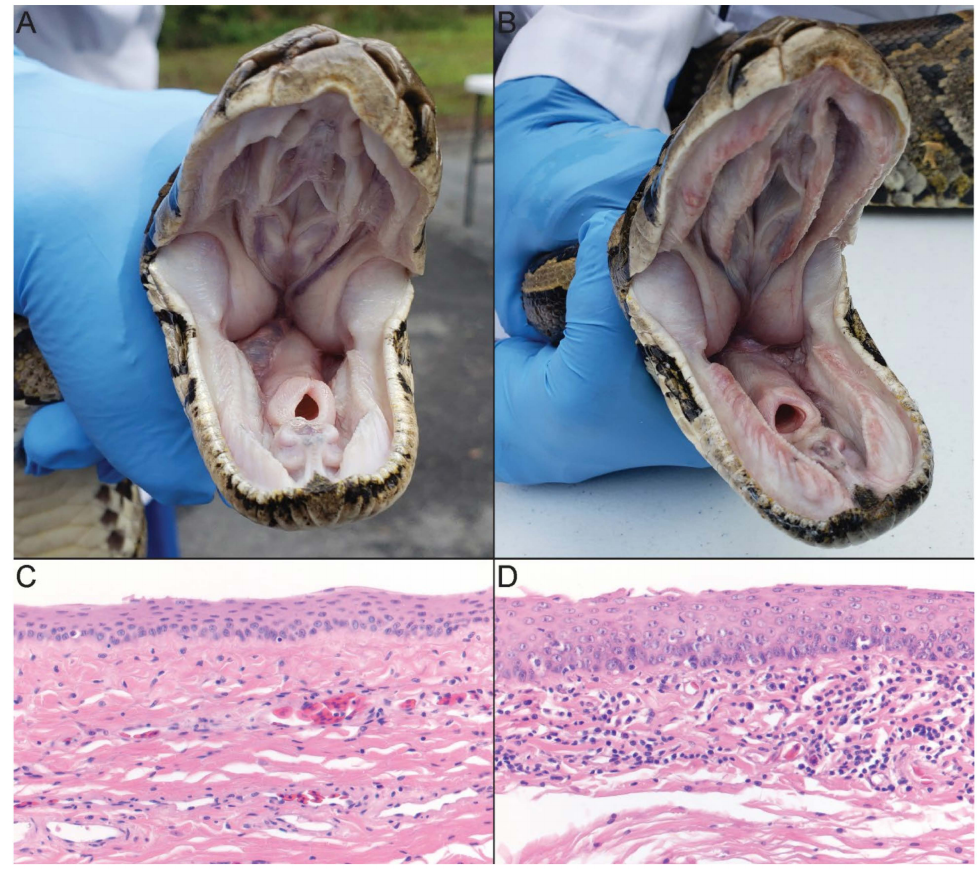
Figure 4. Gross and histologic appearance of the oral cavity of serpentovirus reverse transcription PCR (rtPCR) negative ( A , C ) and positive ( B , D ) Burmese pythons ( Python bivittatus ) from